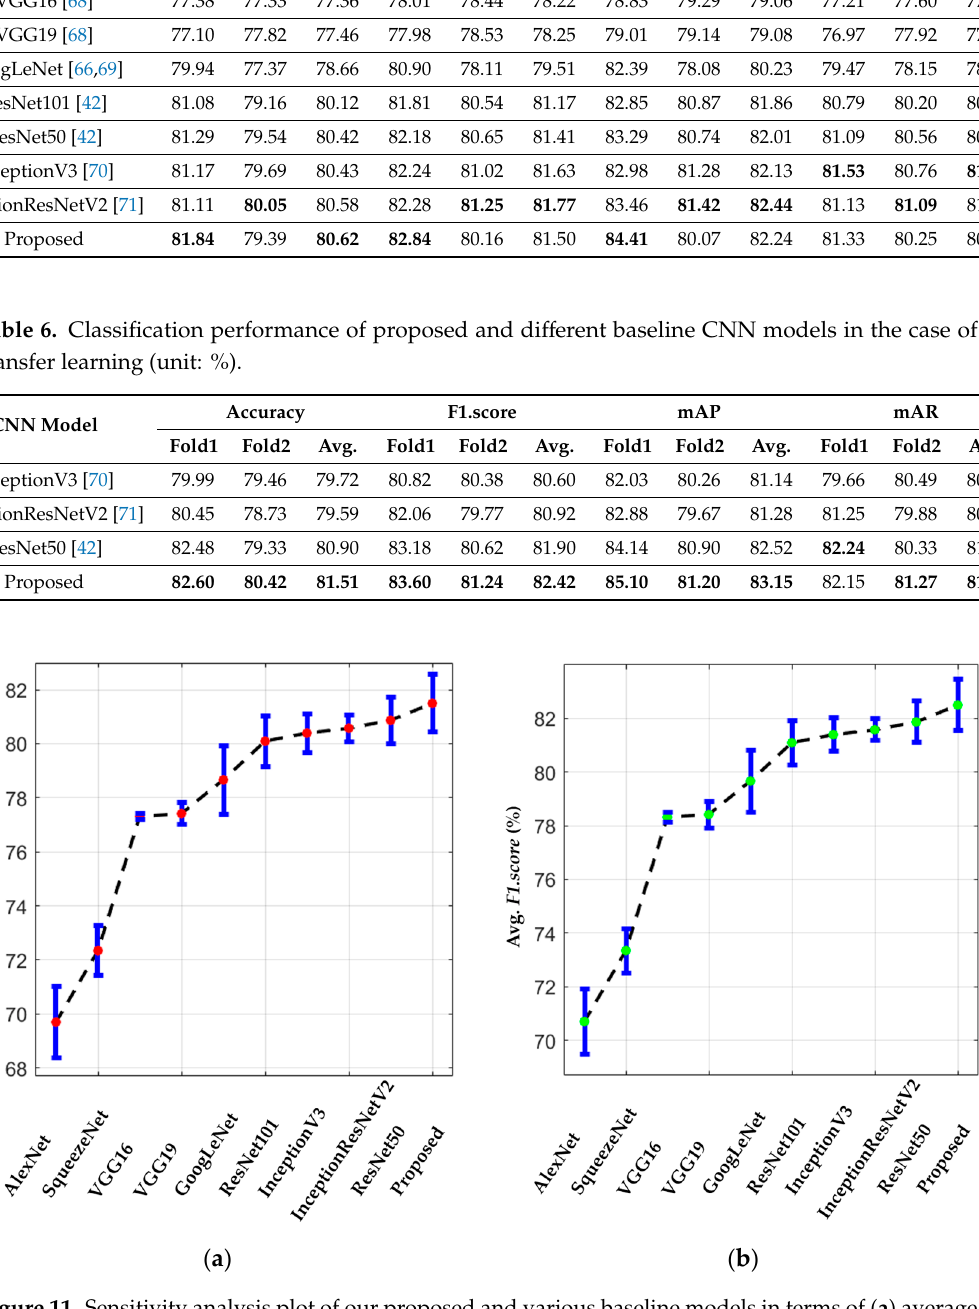
Figure 11. Sensitivity analysis plot of our proposed and various baseline models in terms of (a) average accuracy and (b) average F1.score (unit: %).